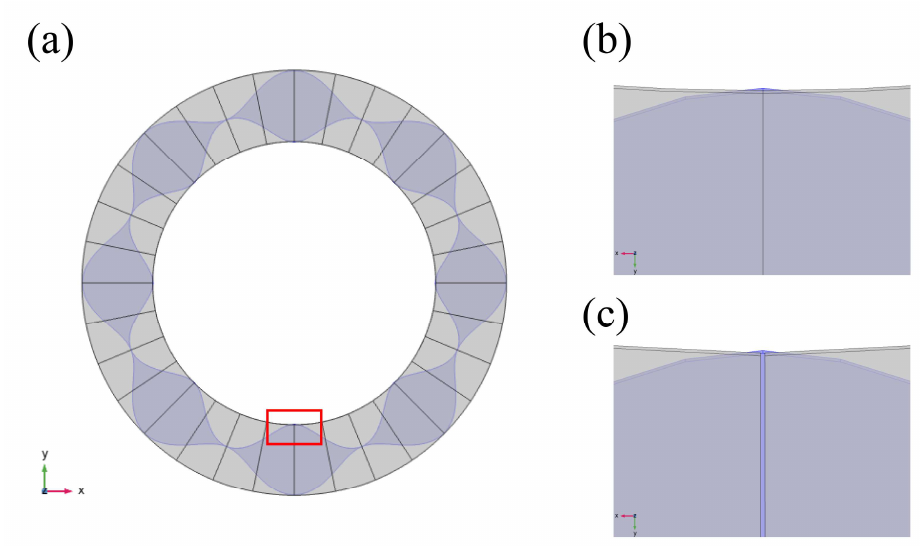
Figure 5. ( a ) Domain of division; ( b ) enlarged section corresponding to the red box in ( a ); and ( c ) improvements made to ( b ).